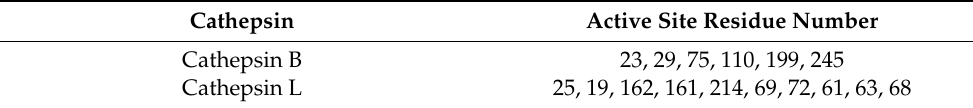
Table 4. Active site residues numbers for grid